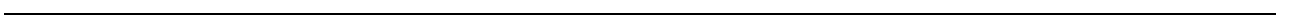
Fig. 4 CXCL12 β discriminates CAF-S1 and CAF-S4 cells. a PCA based on the 500 most variant transcripts differentiating CAF-S1 (red) and CAF-S4 (blue). b HC (500 most variant transcripts) using Ward ’ s method with Euclidean distances. Each column represents a CAF subset and each row a gene. Color saturation shows gene expression deviation from the mean (above in red, below in blue). c Venn diagram showing overlap between mesenchymal signature (de fi ned in ref. 7 ) and CAF-S1 signature (Supplementary Data 1). P value is from hypergeometric test. d Scatter plots of CXCL12 α (NM_000609) or CXCL12 β (NM_199168) mRNA levels in CAF-S1 and CAF-S4 subsets. e , f Venn diagrams showing overlap between genes correlated or anti-correlated with CXCL12 β ( e ) or CXCL12 α ( f ) and CAF-S1 or CAF-S4 signatures (Supplementary Data 1 and 2). P values are from hypergeometric test. g Kaplan − Meier curves of overall survival according to low- and high- CXCL12 β mRNA levels ( N = 53 in low- CXCL12 β subgroup and N = 54 patients in high- CXCL12 β subgroup, Institut Curie). P value is based on log-rank test. h Scatter plots showing CXCL12 β mRNA levels in mesenchymal and non-mesenchymal HGSOC from the Institut Curie, AOCS, and TCGA cohorts. Data (log2 of probeset (203666_at) intensity) are shown as mean ± SEM. P values are from Mann- Whitney test. i Scatter plot showing ratio of CXCL12 α and CXCL12 β expression levels in mesenchymal and non-mesenchymal HGSOC of the Institut Curie cohort. Data are shown as mean ± SEM. P values are from Mann-Whitney test. j , k Representative views of CXCL12 ( j ) and CXCR4 ( k ) immunostaining in HGSOC. Scale bar, 50 μ m (low magni fi cation) and 20 μ m (inset). l Scatter plots showing histological scores (H score) of CXCL12 and CXCR4 proteins. H score corresponds to the percentage of positive cells (in CAF and at epithelial cell surface, arrows in j, k ) multiplied by the staining intensity. Data are shown as mean ± SEM. P values are from Mann-Whitney test. m Representative view of CXCL12 mRNA detected in fi broblasts by in situ hybridization, using RNAscope ® Technology on HGSOC tissue section. Scale bar, 20 μ m (low magni fi cation) and 6 μ m